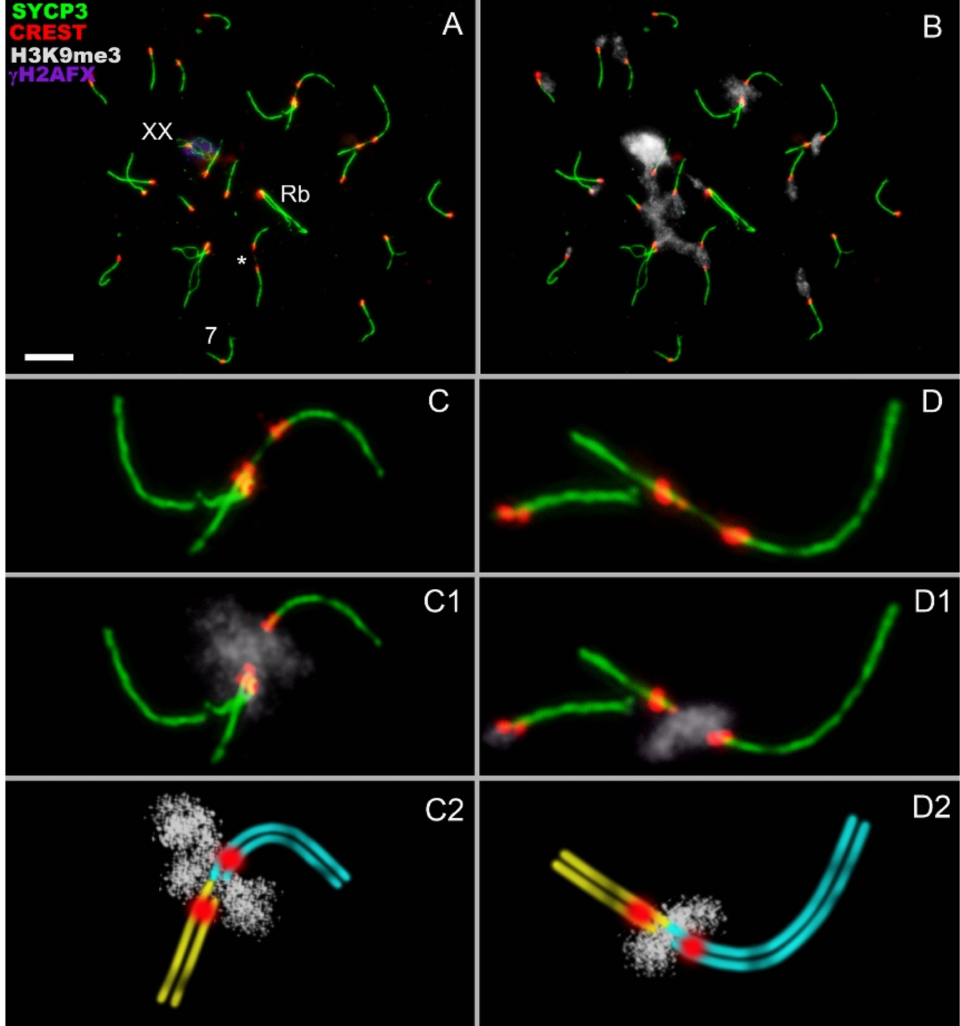
Figure 4. Meiotic contacts of nonhomologous chromosomes and H3K9me3 histone distributions in diplotene of E. alaicus spermatocytes. Immunostained nuclei ( A–D , C1 , D1 ) and schemes of meiotic contacts ( C2 , D2 ) are presented. Lateral elements of the SCs were visualized using the anti-SYCP3 antibody (green). Kinetochores were detected using the anti-CREST antibody (red). Heterochromatin was detected by means of an anti-H3K9me3 antibody (white). Chromatin inactivation was revealed using an anti- γ H2AFX antibody (violet). XX bivalent has a weak γ H2AFX signal ( A ). The non- Robertsonian chromosome is designated as 7 according to the karyotype (A). The contact regions of nonhomologous bivalents are localized in the H3K9me3 clouds. The proximity type of contact marked by an asterisk. Scale bar (A,B) = 5 µ